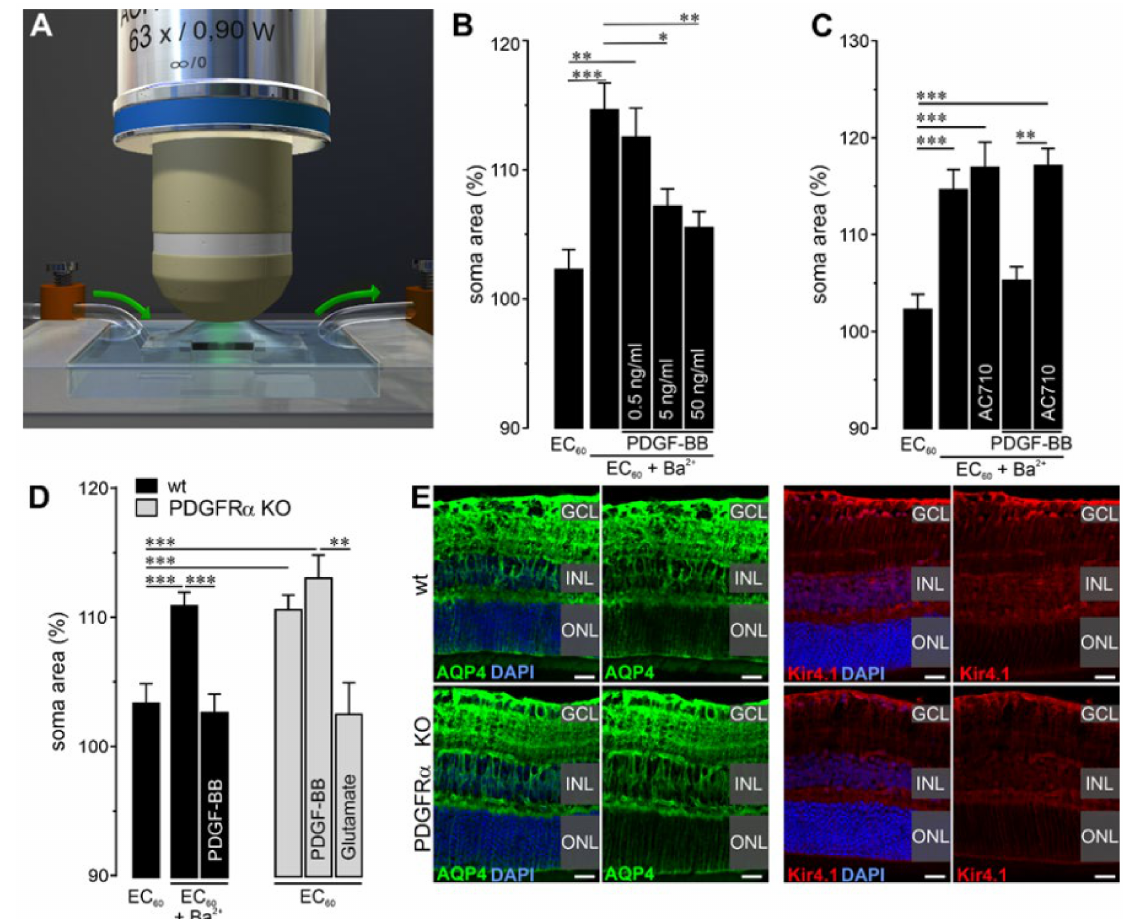
Figure 3. Dysfunctional volume homeostasis in PDGFR α -deficient Müller cells. ( A ) Scheme of the experimental setup to determine Müller cell volume regulation. Vital retinal slices were stained with Mitotracker Orange and were examined via confocal scanning microscopy while hypotonic solution was washed into the recording chamber. ( B ) In wildtype Müller cells, PDGF-BB showed a dose-dependent effect, preventing the swelling of Müller cells induced by the co-application of barium ions (1 mM, Ba 2+ ) and exposure to 4 min of hypoosmotic stress (60% osmolarity). ( C ) AC710, a potent PDGFR family inhibitor (100 µ M), abolished the protective action of PDGF-BB (50 ng/mL) in Müller cells from wildtype animals. ( D ) In the absence of PDGFR α , Müller cells were not able to counterbalance volume changes under hypoosmotic stress as efficiently as their wildtype counterparts. Administration of the PDGFR α ligand PDGF-BB (50 ng/mL) did not prevent cell volume changes in Müller cell-specific PDGFR α KO retinae. In contrast, glutamate (1 mM) efficiently blocked cell swelling of PDGFR α -deficient Müller cells under hypoosmotic stress. Experiments on wildtype littermates were repeated, combining barium ions and PDGF-BB to demonstrate no adverse effect of tamoxifen treatment on key findings observed in ( C ). ( B – D ) Bars represent mean ± SEM and data were collected from 15–34 cells isolated from 2–3 animals of each genotype. * p < 0.05, ** p < 0.01; *** p < 0.001. ( B ) * Changes in soma were tested after 4 min of exposure to hypoosmolar (60% osmolarity) extracellular solution (EC 60 ) with a Mann–Whitney U-test. ( E ) Representative images of immunofluorescent detection of the water channel aquaporin 4 (AQP4) and the potassium channel Kir4.1 in Müller cell-specific PDGFR α KO retinae and wildtypes. Both proteins were enriched in Müller cell end feet facing the vitreous and blood vessels. There was no discernible phenotype in terms of immunoreactivity or distribution of Kir4.1 and AQP4. GCL, ganglion cell layer; INL, inner nuclear layer; ONL, outer nuclear layer. Scale bars, 20 µ